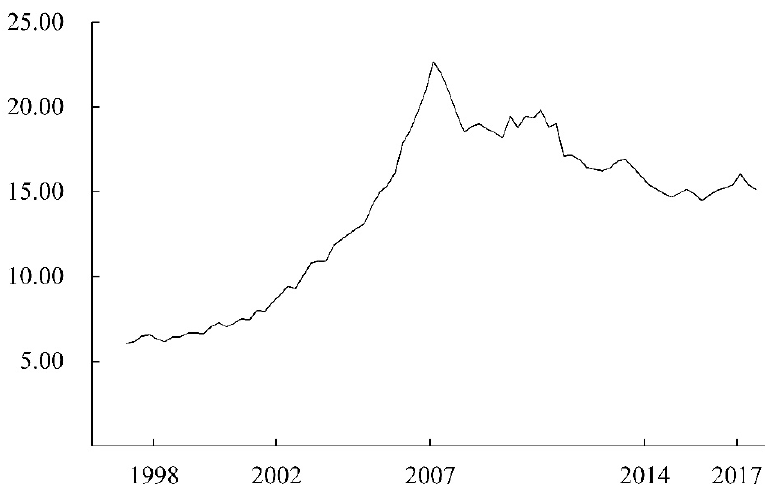
Figure 1. Cross-border bank lending, 1998Q1–2018Q3: Claims (in trillions of US dollars) on bank sector of banks in all reporting countries. Source: Locational statistics, International banking, BIS Statistics.